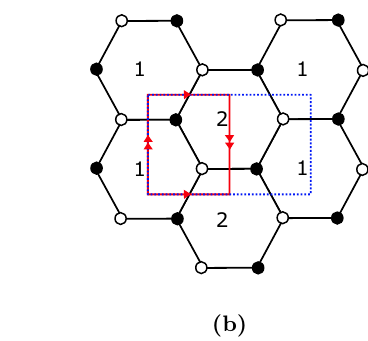
Figure 3. (a) Dimer diagram for the orbifold C 2 / Z 2 × C . The unit cell and the reflection axis are depicted in blue and red respectively. (b) The Klein bottle we obtain with the orientifold